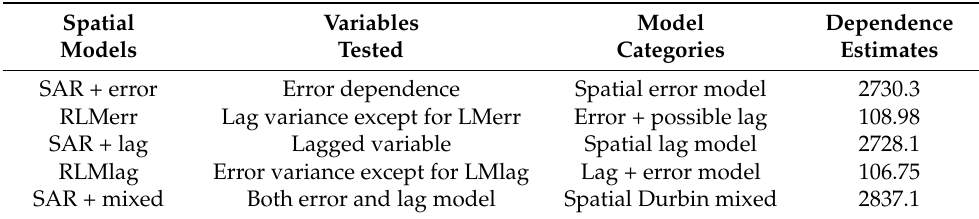
Table 12. Comparison among five autoregressive-based models from the Lagrange multiplier test